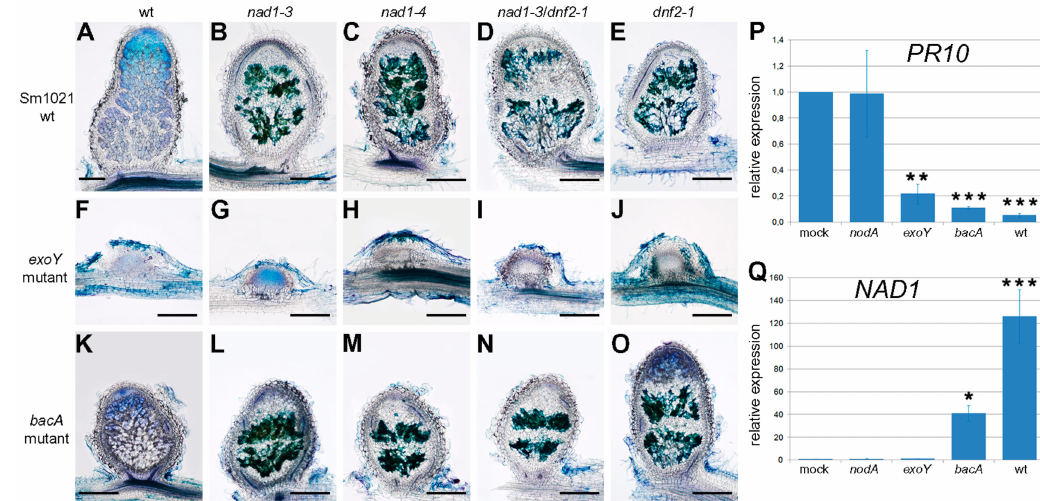
Figure 6. Positioning of the function of NAD1 in the symbiotic process. Sections of wild-type ( A , F , K ), nad1-3 ( B , G , L ), nad1-4 ( C , H , M ), nad1-3/dnf2-1 ( D , I , N ), and dnf2-1 ( E , J , O ) nodules were stained with toluidine blue to detect accumulation of phenolic compounds 14 dpi with wild-type S. meliloti 1021 ( A – E ) or its exoY ( F – J ) and bacA ( K – O ) mutant derivatives. Nodule primordia induced by exoY mutant rhizobia displayed no staining of polyphenols, but mutant nodules elicited by S. meliloti wild-type or bacA mutant stained dark green showing the accumulation of phenolic compounds which indicates that NAD1 acts prior bacterial differentiation. Scale bars: ( A – O ) 200 µ m. The PR10 and NAD1 genes are expressed inversely in nodules containing released rhizobia in 14 dpi nodules ( P , Q ). The relative expression level of PR10 and NAD1 was analyzed in wild-type (Jemalong) nodules with quantitative RT-PCR 14 dpi with wild-type and mutant S. meliloti 1021 derivatives blocked at different stages of the symbiotic process. The transcript levels were calculated relative to the expression detected in non-infected roots (mock). Values of relative transcript levels are the mean of three biological replicates. Error bars indicate ± SE. ***, ** and *, p ≤ 0.001, 0.01 and 0.05,